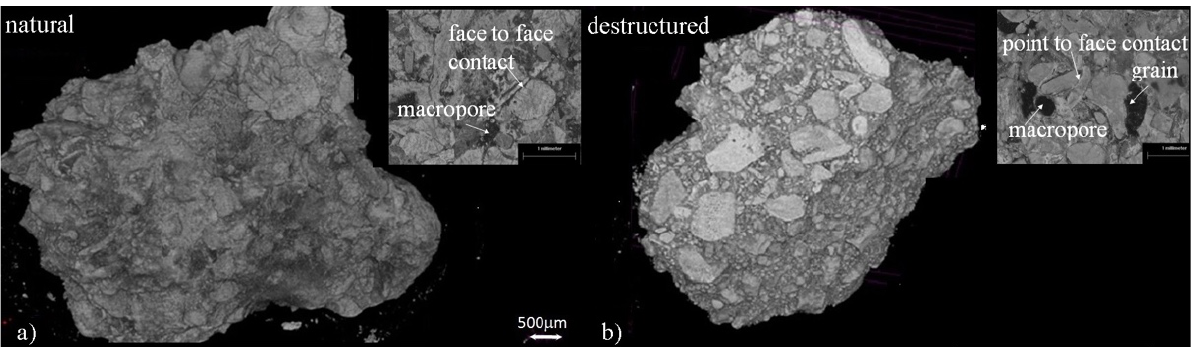
Figure 5. Micro-CT images from the Bruker Skyscan: ( a ) after oedometer test ON4; ( b ) after oedometer test OD9.